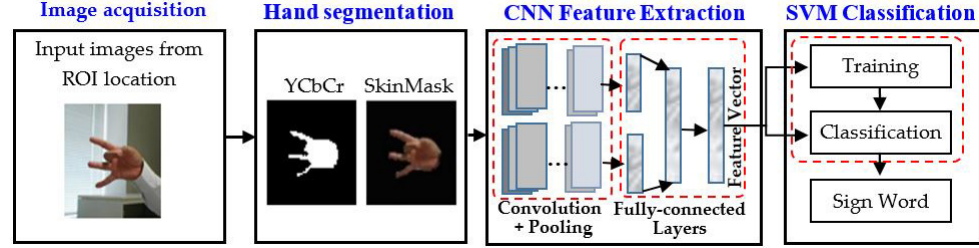
Figure 1. Proposed approach of the sign word recognition